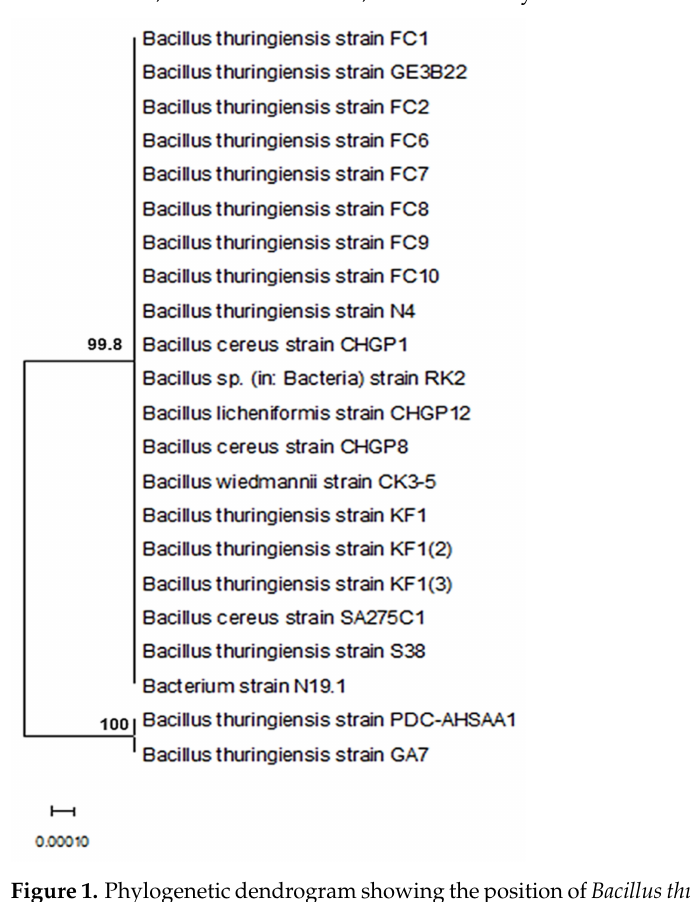
Figure 1. Phylogenetic dendrogram showing the position of Bacillus thuringiensis strain PDC-AHSAA1 among phylogenetic